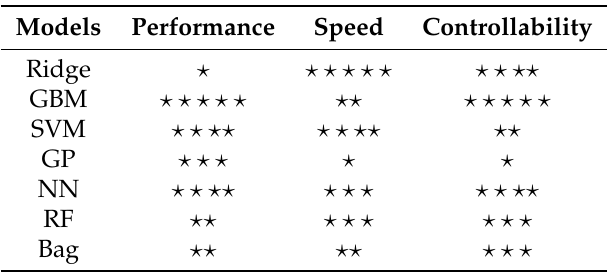
Table 5. Forecasting machines